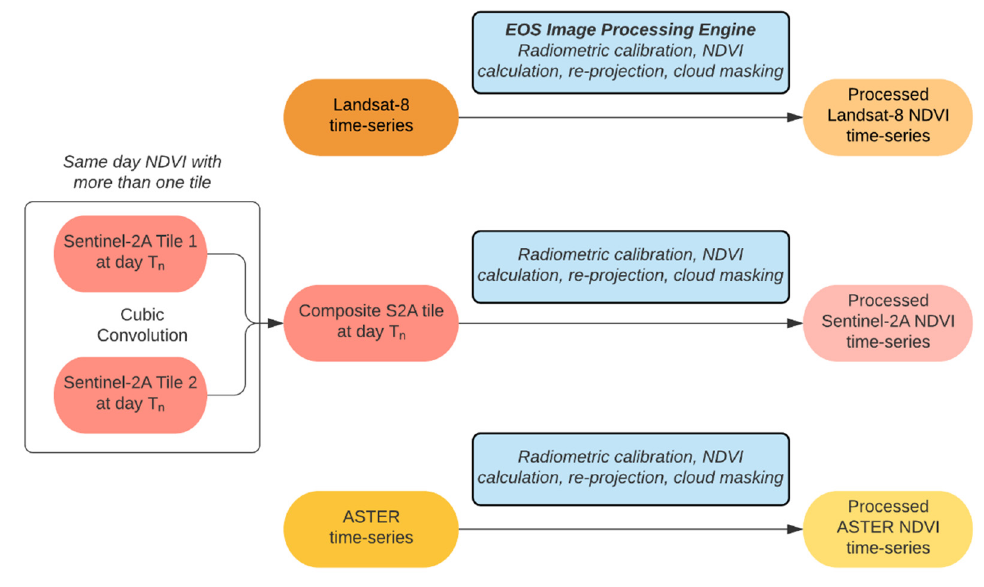
Figure 2. Image pre-processing workflow. T n represents a given satellite image acquisition date.